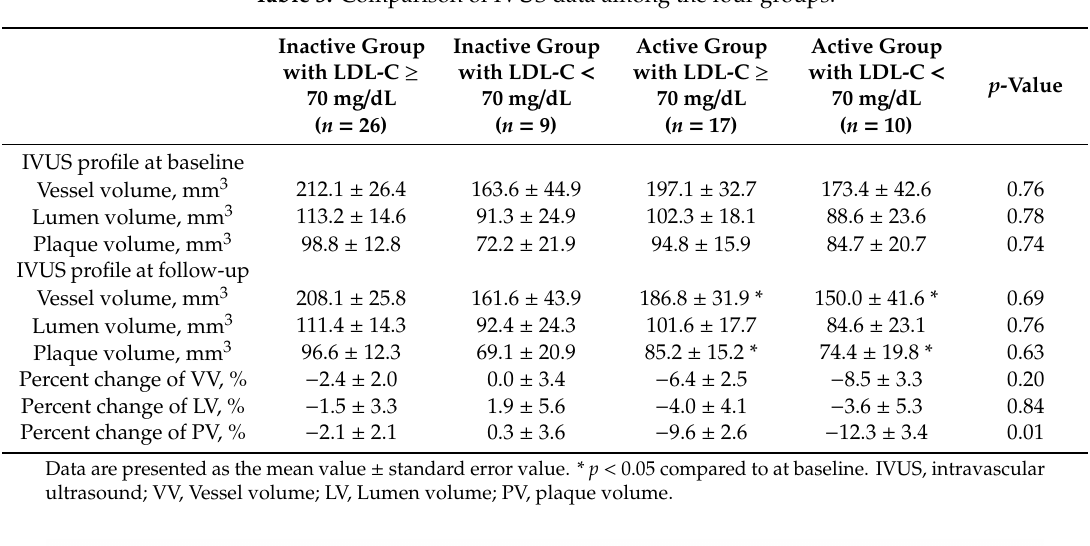
Table 3. Comparison of IVUS data among the four groups.